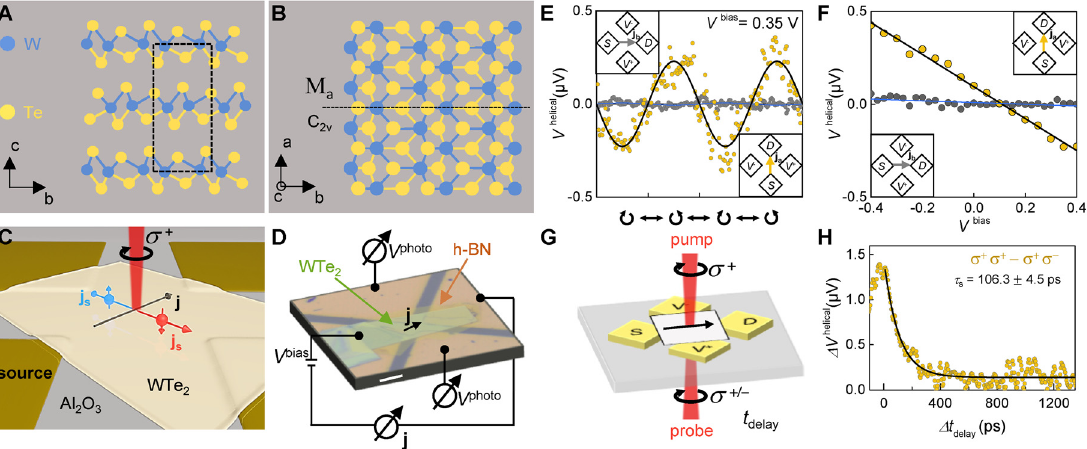
Figure5: Photo-inducedHalleffectinfew-layerWTe 2 atroomtemperature.(A)Sideviewonthecrystalstructureofbulk T d – phaseWTe 2 .Here, a and b denotethe in-planeandc the out-of-plane crystalaxis directions. Inthe T d – phase,inversionsymmetryis broken along theb axis.(B) Top view of the crystal structure of T d – WTe 2 . The crystal exhibits a mirror plane M a orthogonal to the a-axis. (C) and (D) Schematic of an anomalousHalleffectinafour-terminalcircuitinducedbyilluminationwithcircularlypolarizedlight.Alongitudinalbiascurrentisappliedand the transversal photo-induced Hall voltage is measured. The a and b crystal axes of the WTe 2 are aligned along the contacts. (E) and (F) Anisotropic photo-induced Hall voltage as function of circular polarization and bias voltage. For a current applied along the b -axis, no Hall effect is observed, and the photo-induced Hall effect is linear in bias voltage. (G) and (H) Optoelectronic pump-probe scheme to read out the ultrafast dynamics of the photo-induced Hall effect. Reproduced with permission [181]. Copyright 2019, American Physical